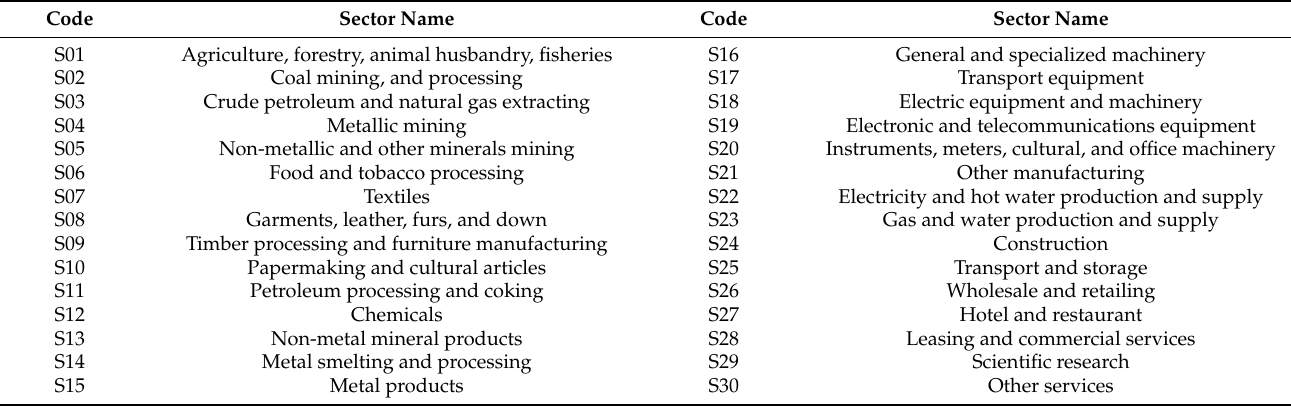
Table 1. Sectors in the input–output table.